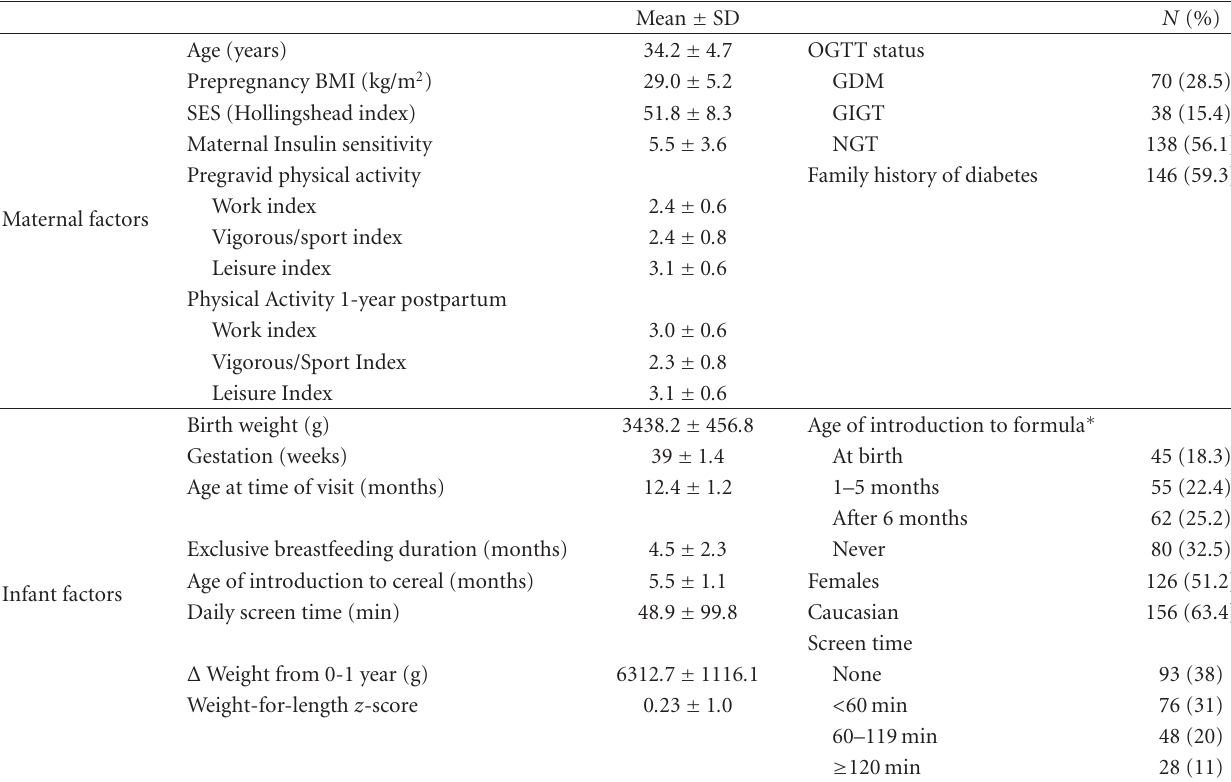
Table 1: Maternal and infant descriptive characteristics ( n = 246).